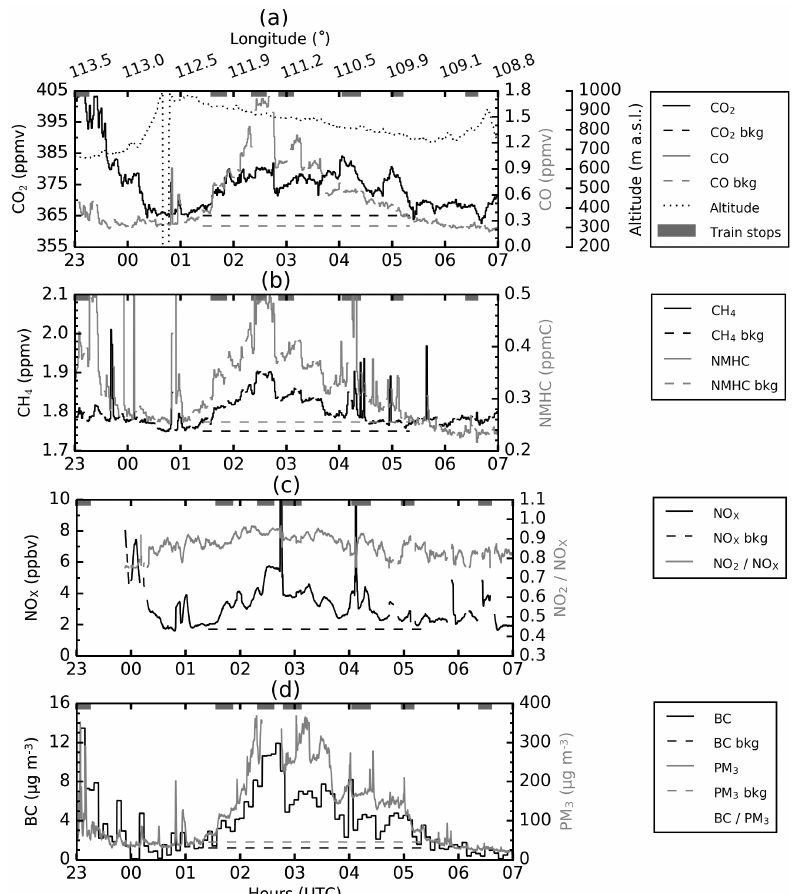
Figure 4. Measured 10s trace gas mixing ratios and aerosol mass concentrations observed in the vicinity of the F2 forest fire plume during TROICA-11 expedition on 1 August 2007. Local time is UTC +